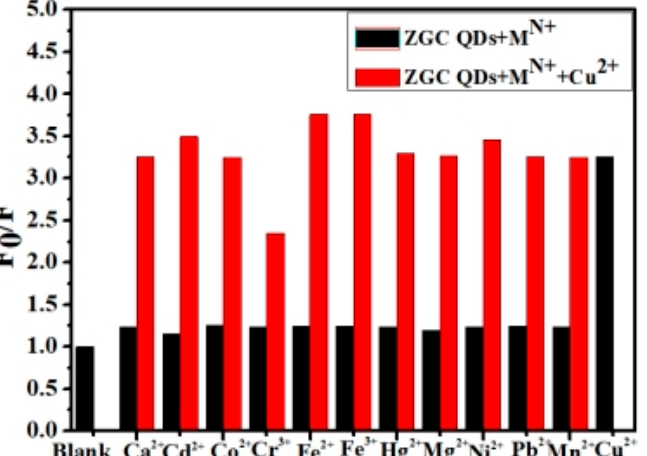
Figure 4. Relative fl uorescence intensity of ZCGQDs in the coexistence of Cu 2+ with other metal